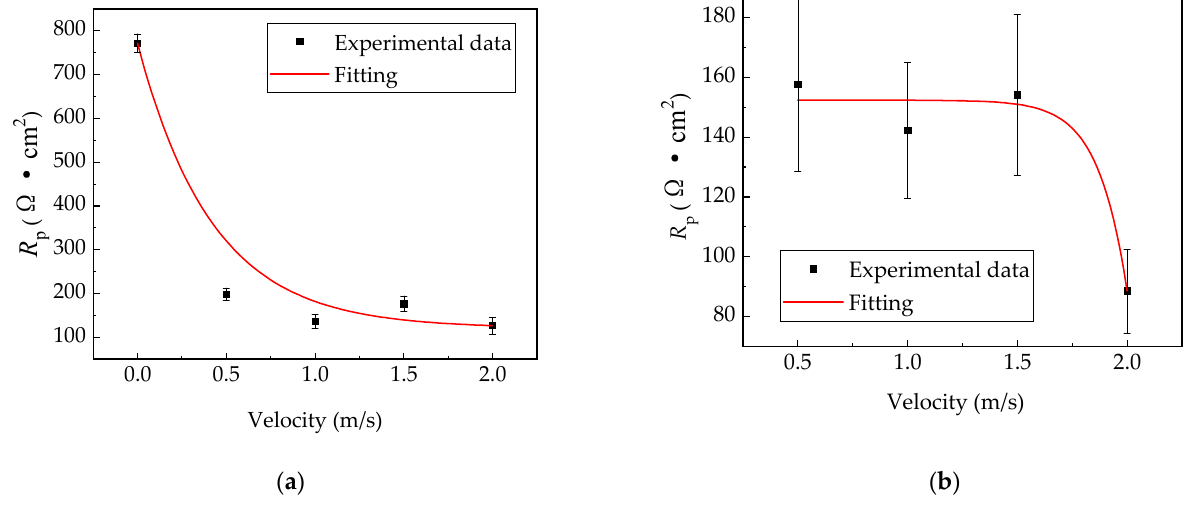
Figure 5. Diagram of a relationship between velocity and R p in oil-water flow: ( a ) without sand, ( b ) 2 wt% sand.